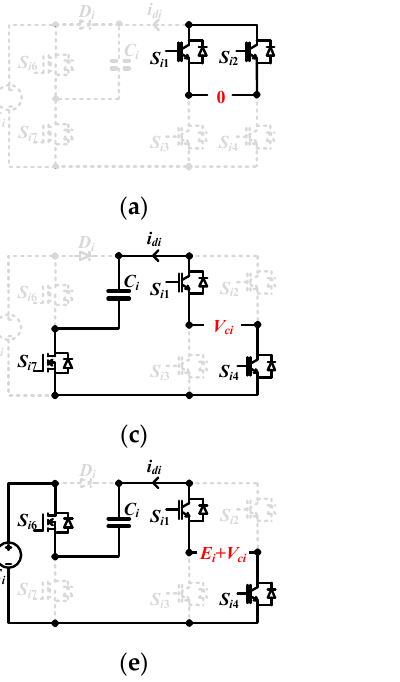
Figure 4. Switching modes of the inverter in [23] under inductive load. ( a ) Mode 1, ( b ) Mode 2, ( c ) Mode 3, ( d ) Mode 4, ( e ) Mode 5, ( f ) Mode 6.